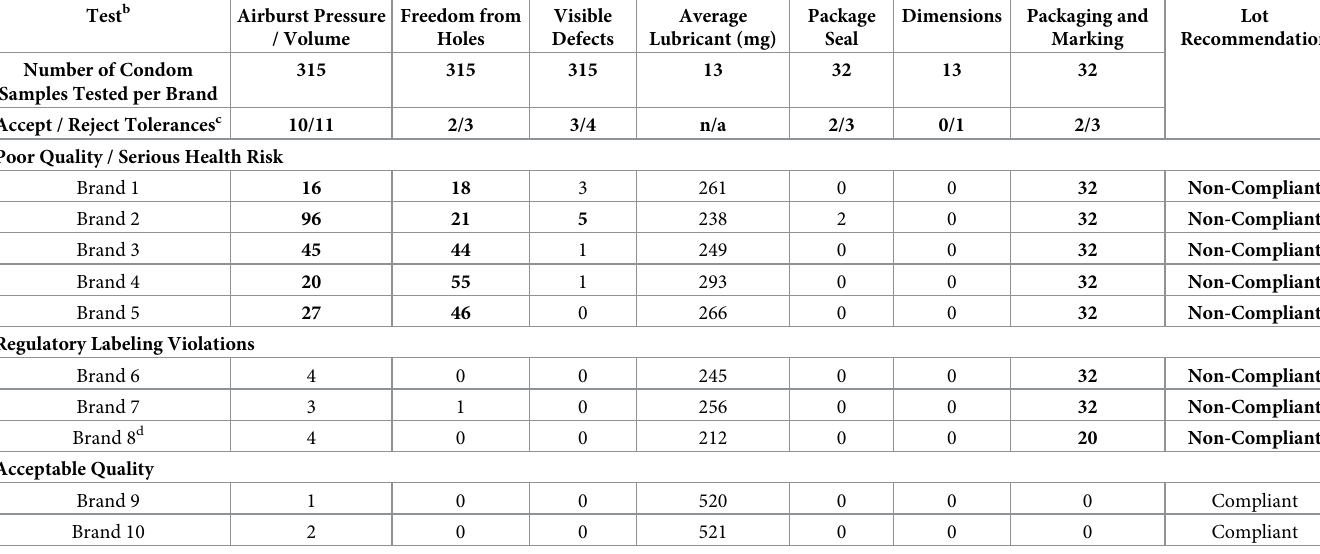
Table 1. ISO 4074 test results for sampled brands of male latex condoms from the Dominican Republic. a Except for the average lubricant quantity (mg), the values presented for each brand / test combination represent the number of failing samples